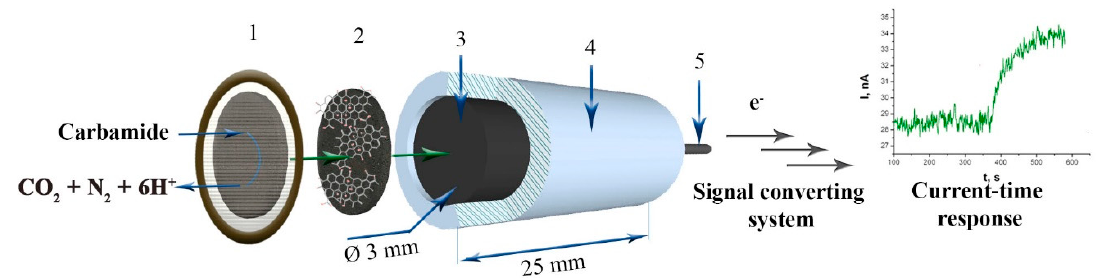
Figure 1. Principle scheme of the thermally reduced graphene oxide -based urea biosensor. 1 and 2—adjustable membrane containing semipermeable terylene film (1) and TRGO layer with immobilized urease (2), 3—electrode contact zone, 4—housing, 5—connection to a response registration device.